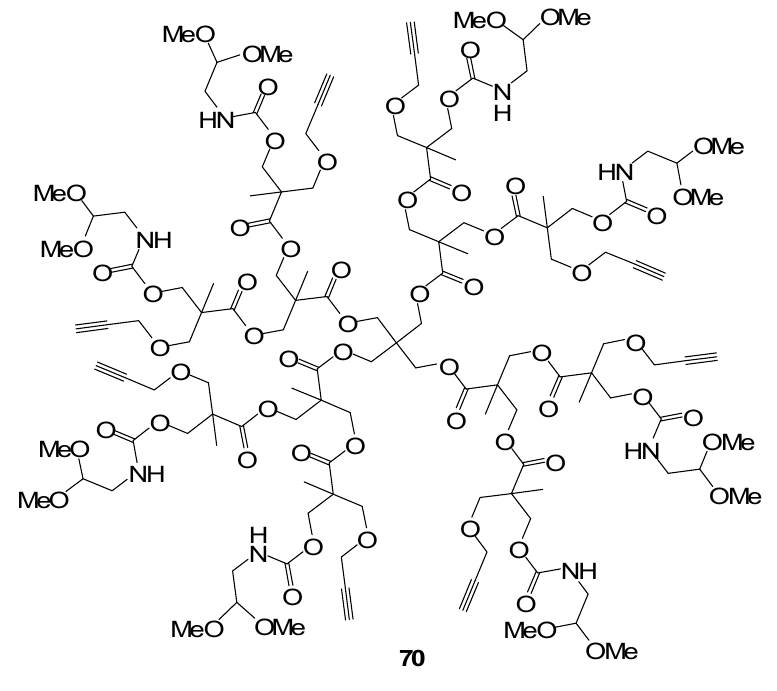
Figure 5. Second generation dendrimer having a bifunctionalized periphery